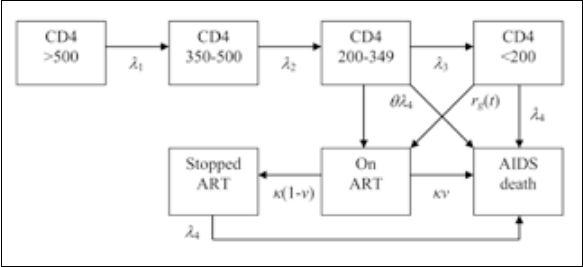
Fig. 1. Multi-state model of decline in CD4 count and ART initiation by HIV-infected adults. All states are stratified by age and sex, and all HIV- infected adults are assumed to experience age-specific mortality unrelated to HIV (not